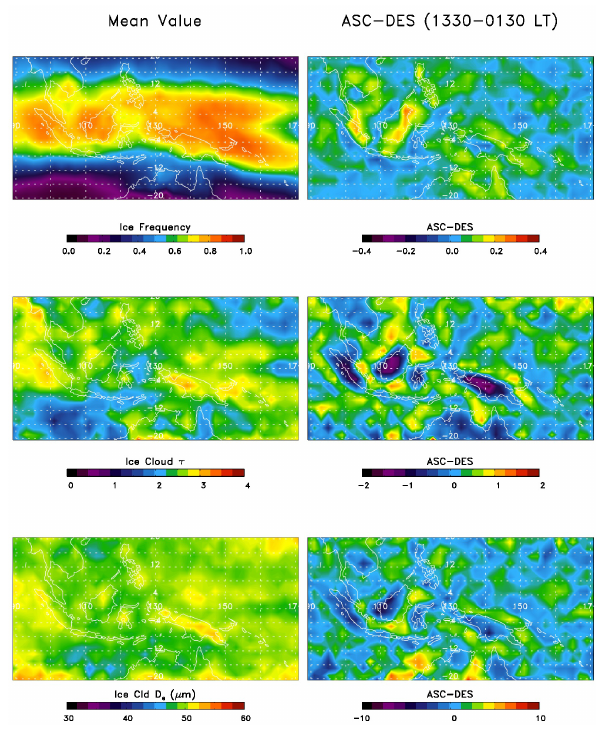
Fig. 14. AIRS diurnal variations of ice cloud properties over the Maritime Continent during 2007 for the mean value (left column) and the ascending–descending differences (13:30–01:30LT, right column). Shown are ice cloud frequency (top row), τ (middle row), and D e (bottom